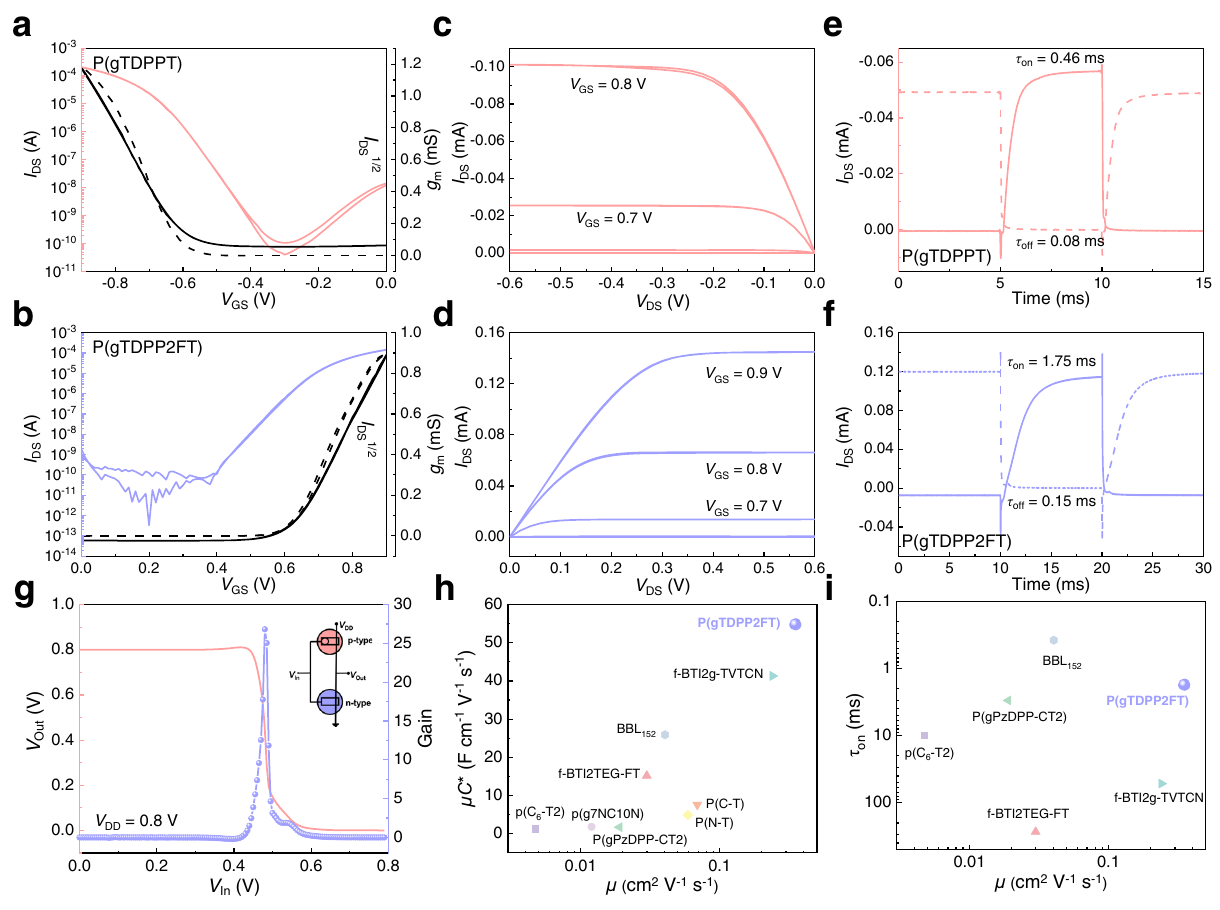
characteristics and gain of the complementary inverter based on P(gTDPPT) and P(gTDPP2FT). Insert is the circuit diagram of the complementary inverter. Device con fi guration: W/L =100/10 μ m. Comparison of the h μ C * and μ , and